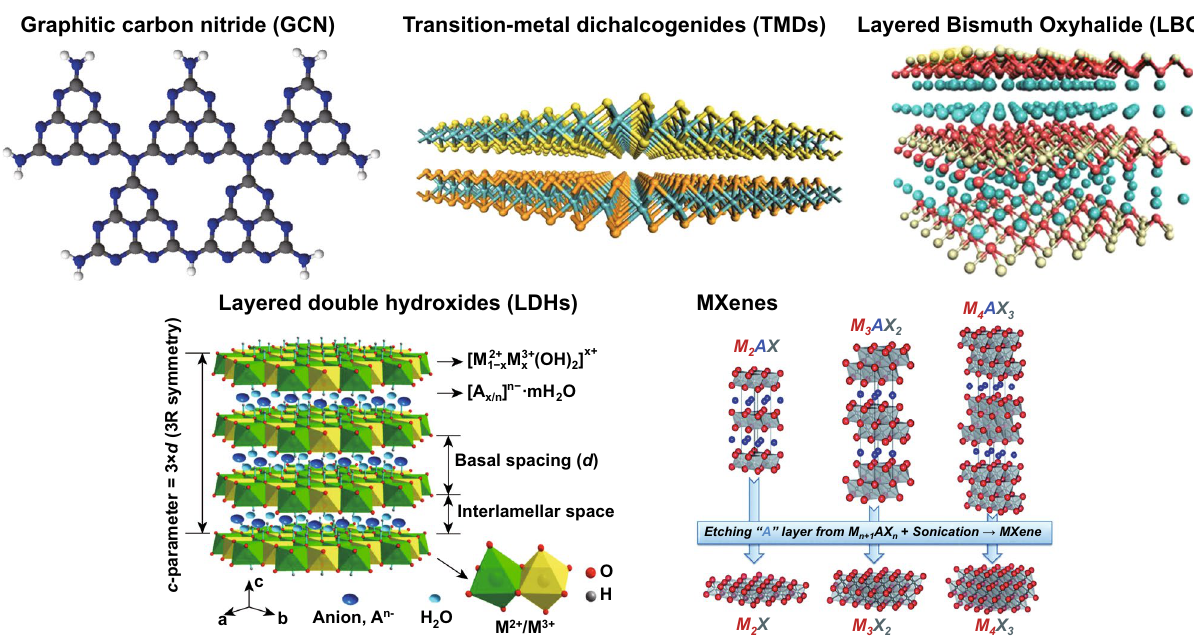
Fig. 1 Crystal structures of various 2D layered materials used in PEC solar energy conversion [172, 184–187]. Copyright 2017 and 2016 Amer- ican Chemical Society, 2015 Royal Society of Chemistry, 2013 Springer Nature and 2017 MDPI (Basel,